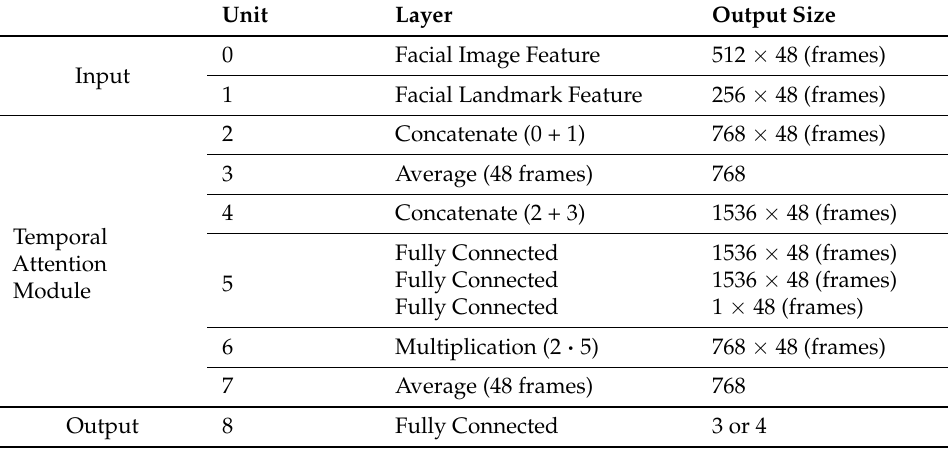
Table 4. Network structure of the temporal attention